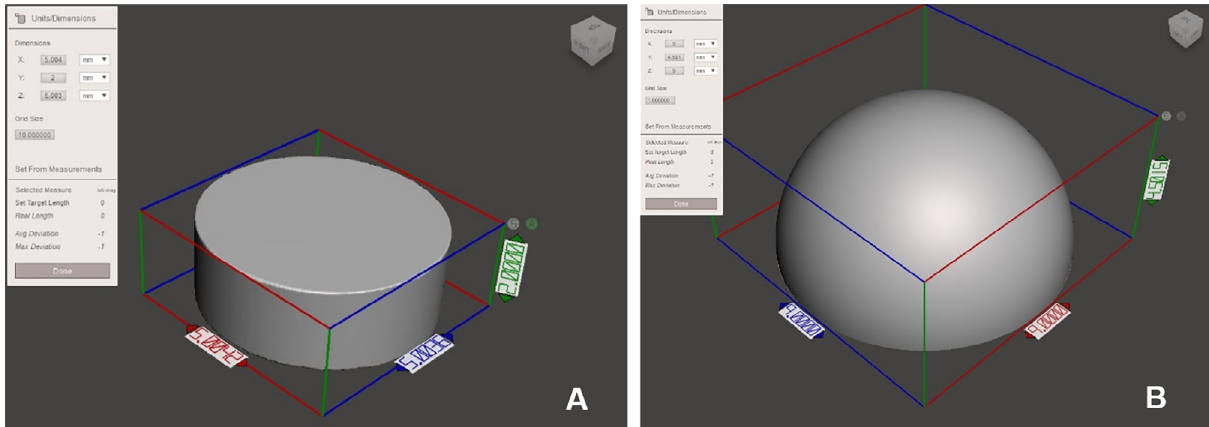
Figure 1- Computer-assisted design of the titanium